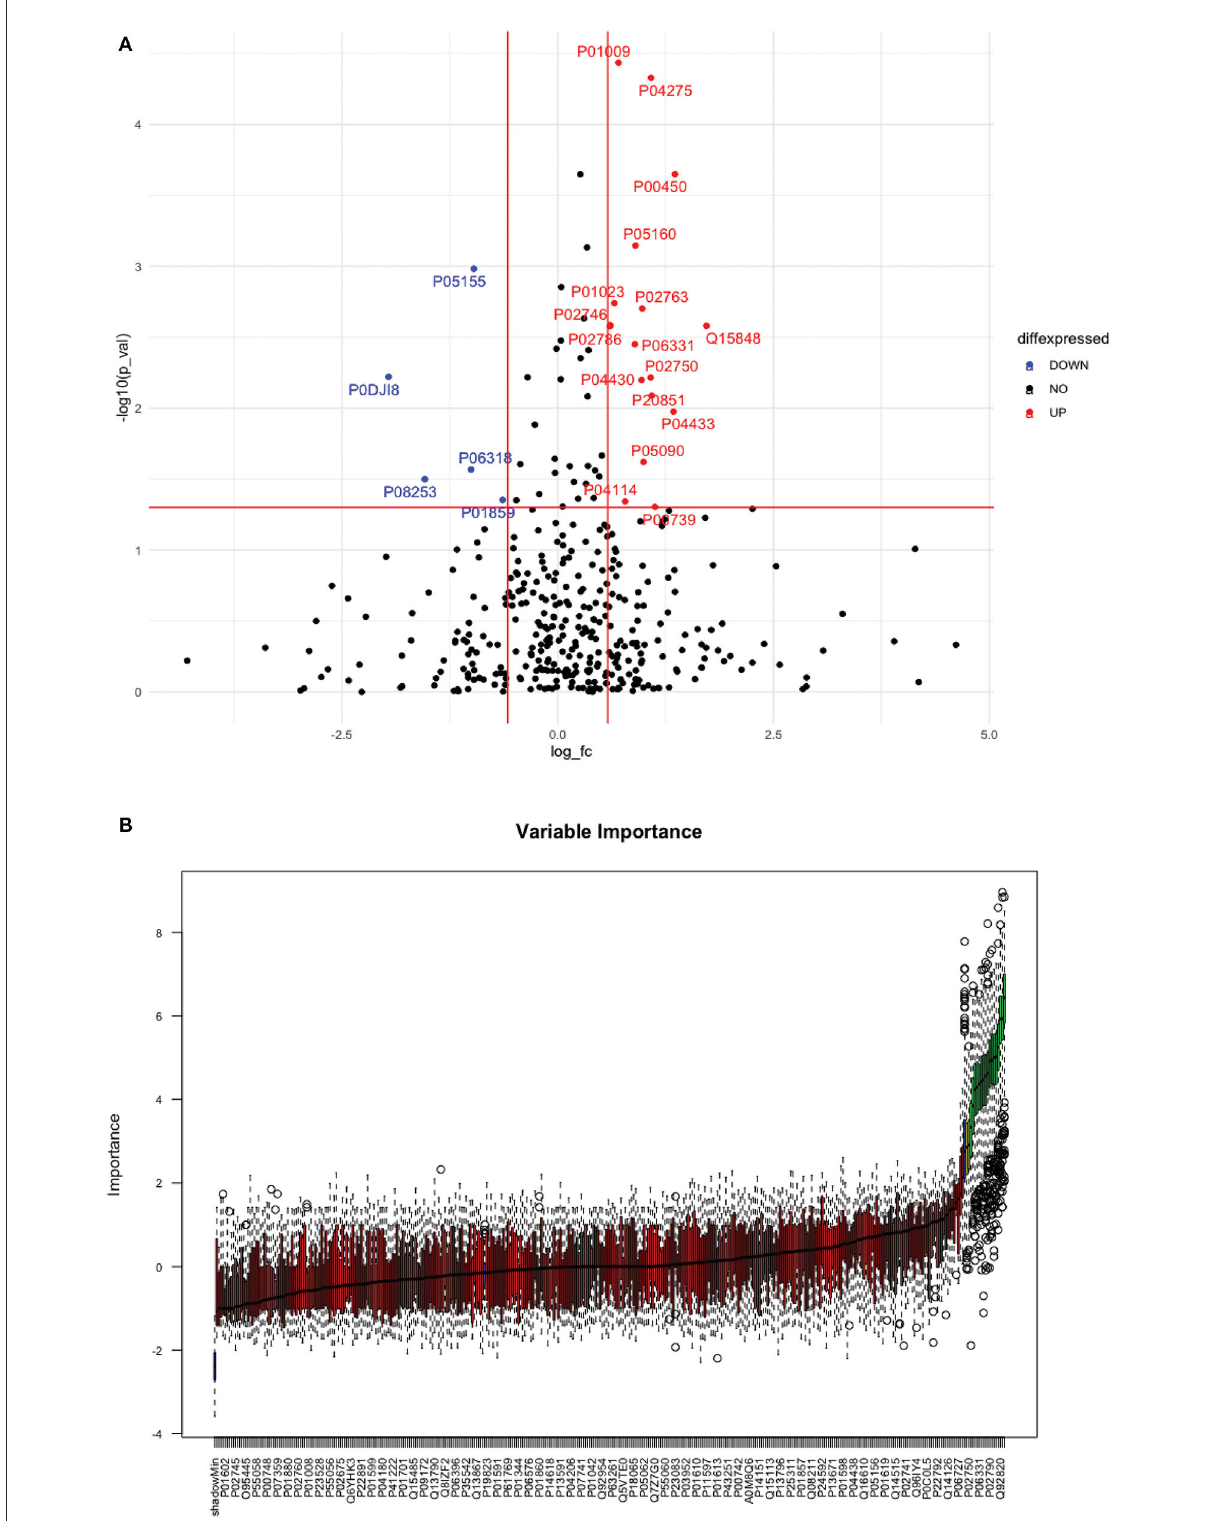
FIGURE2 (A) Volcano plot depicting the log 2 fold change on the x-axis and -log10 p- value on the y-axis for the upregulated and downregulated proteins in 40 total stroke cases compared to 40 healthy controls. The two vertical lines represent the threshold for log2 fold change ( > 0.58 and < − 0.58), and the horizontal line represents the threshold for log10 p- value ( > 1.3). The red dots on the graph indicate the proteins which are